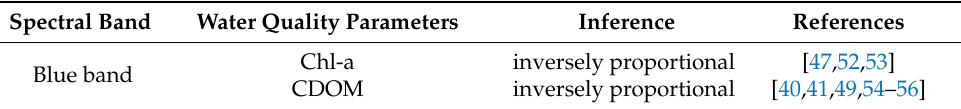
Table 2. List of spectral bands and their relationship with water quality parameters. Spectral Band Water Quality Parameters